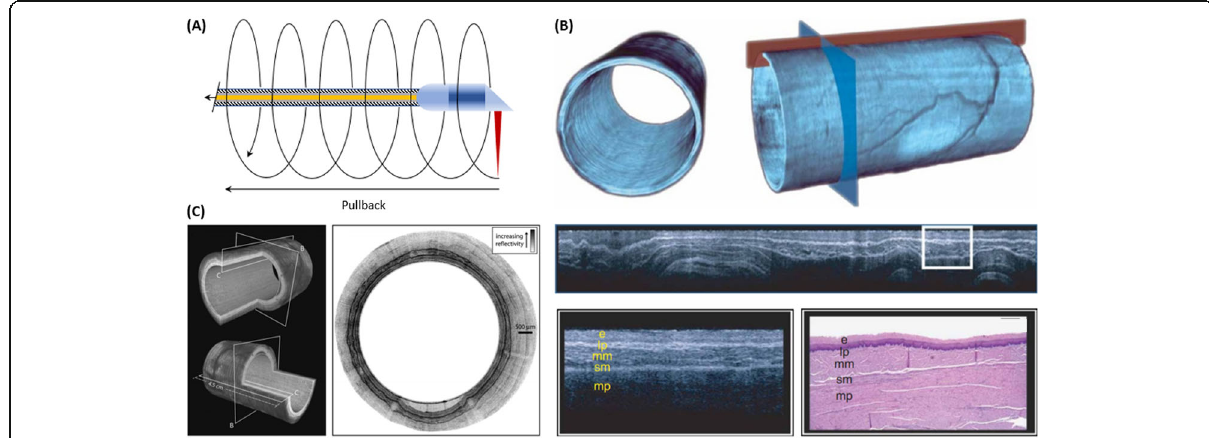
Fig. 4 Milestone 2: FD-OCT enables comprehensive 3D endoscopic imaging results. a Illustration of helical scanning scheme (side-viewing rotation + pullback). b and c depict reprints from landmark papers of first preclinical demonstrations of endoscopic FD-OCT, in vivo . b shows a 3D rendering of data recorded in the esophagus of a living swine as well as cross sectional data details and a comparison to histology (figure and caption adapted and reprinted with permission from [69] © Springer Nature ). c depicts a balloon-centered 3D dataset and a 2D cross-section of the distal esophagus of a swine in vivo (figure and caption adapted and reprinted with permission from [71] © American Society for Gastrointestinal Endoscopy